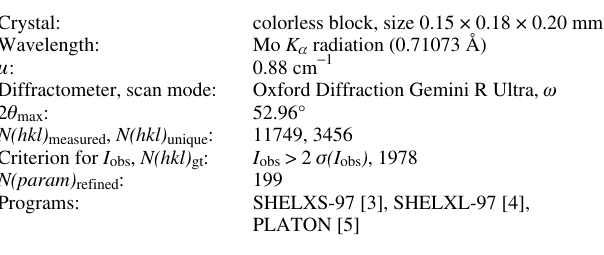
Table 1. Data collection and handling.